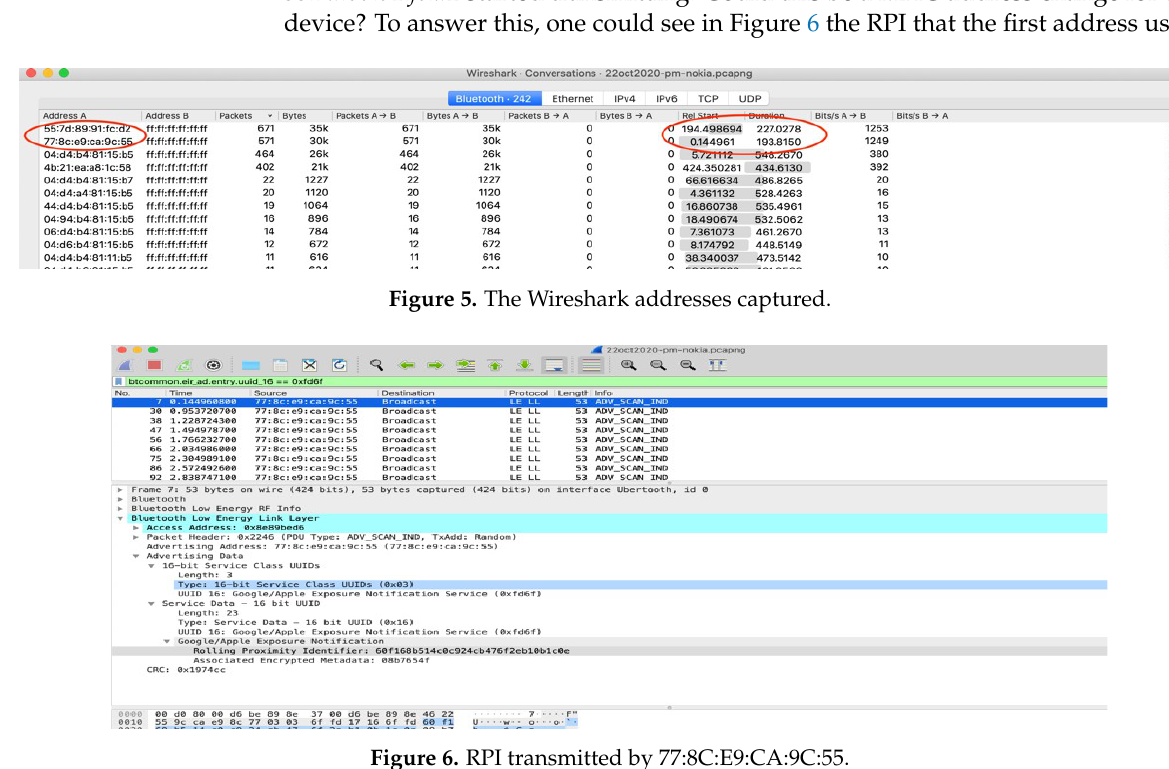
Figure 6. RPI transmitted by